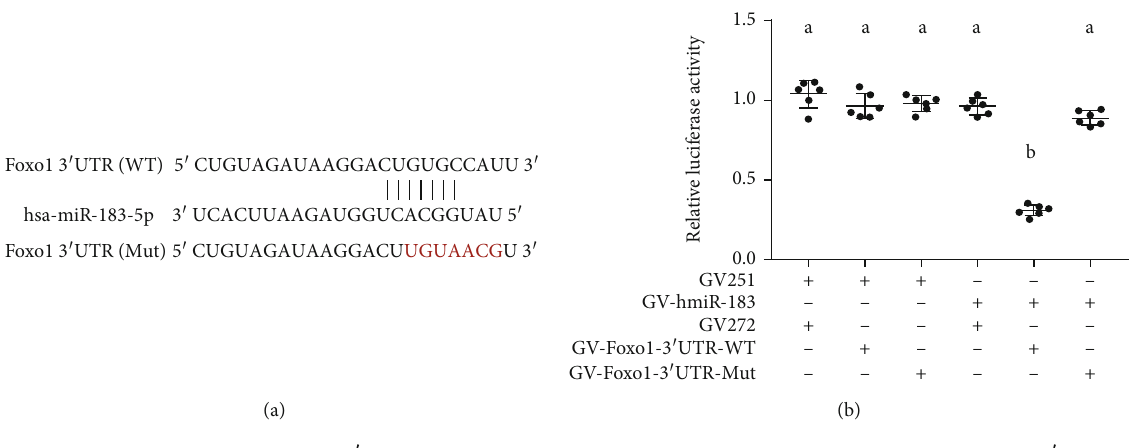
Figure 8: miR-183-5p directly targets Foxo1 3 ′ UTR. (a) The binding site of miR-183-5p and the position 226-242 of Foxo1 3 ′ UTR wild-type (WT) and mutant-type (mut). (b) miR-183-5p ectopic expression signi fi cantly inhibited luciferase activity of the wild-type Foxo1 3 ′ UTR reporter plasmid in comparison with the mutated counterpart. Groups labeled with di ff erent letters are statistically di ff erent from each other. ∗ p < 0 : 05 . Di ff erences between groups were analyzed for statistical signi fi cance by ANOVA with Fischer ’ s probable least-square di ff erence post hoc